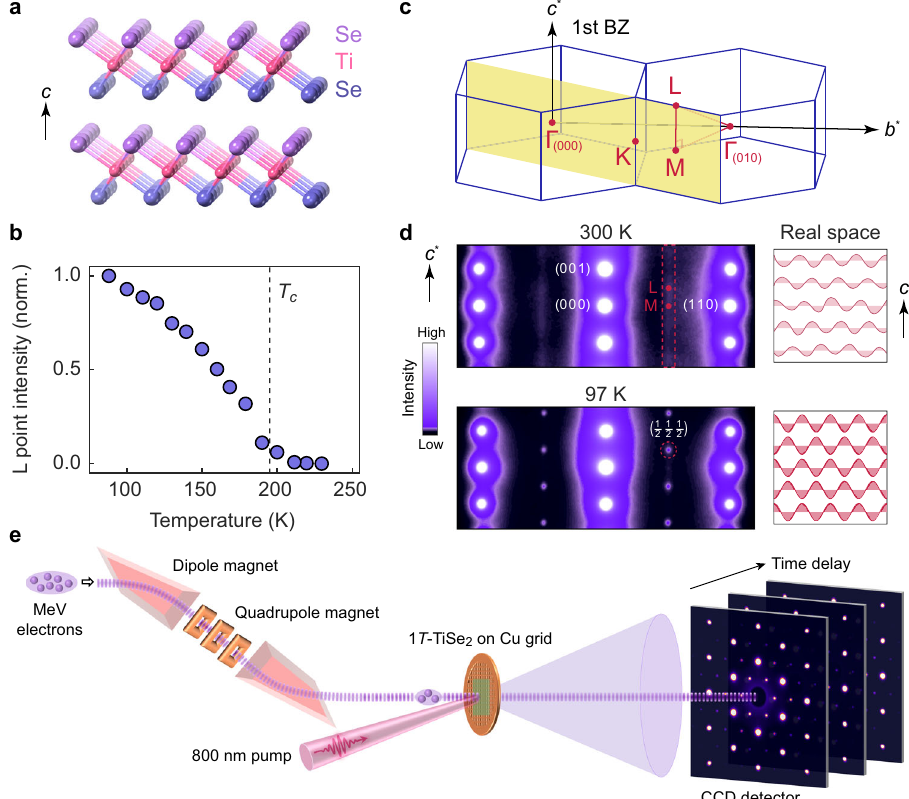
Fig. 1 Equilibrium charge density wave transition in 1 T -TiSe 2 . a Crystal structure of 1 T -TiSe 2 in the non-CDW state. Layers are bonded by van der Waals forces and each Ti atom is octahedrally coordinated with six Se atoms, where upper and lower Se atoms are colored differently. b Temperature-dependent (cid:1) (cid:3) 1 1 intensity evolution of the 1 CDW peak, which is located at the L point in the Brillouin zone (BZ). Intensity is normalized by the value at 88 K. c Brillouin 2 2 2 zones of 1 T -TiSe 2 with high symmetry points labeled. The yellow plane corresponds to the diffraction plane in ( d ). d Static electron diffraction patterns in the ½ 1 (cid:1) 10 (cid:2) zone axis above and below the CDW transition temperature, T c ≈ 195 K. Diffuse streaks along the M – L line at 300 K (dashed rectangle) is transformed into sharp superlattice peaks at the L point at 97 K (dashed circle). Schematics on the right show the real space con fi gurations of CDWs in different layers. e Schematic of the ultrafast electron diffraction setup, where a double-bend achromatic lens consisting of a pair of dipole magnets and three quadrupole magnets are used to compress the electron pulse and to reduce the timing jitter (see “ Methods ”